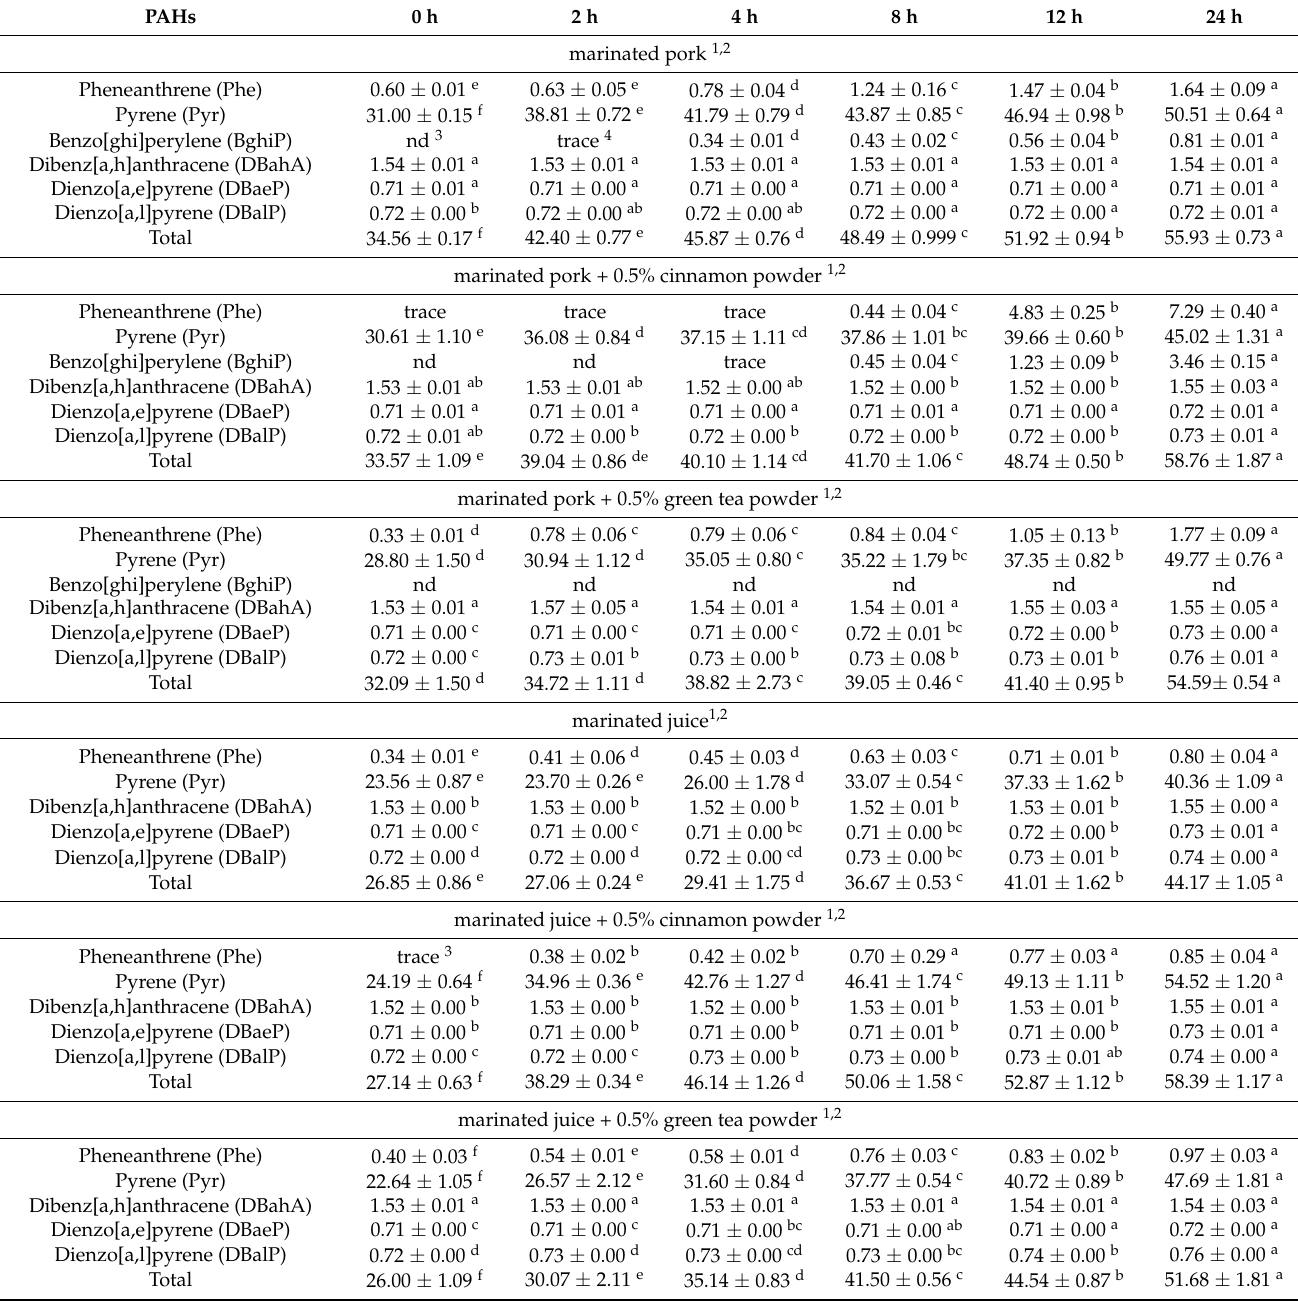
Table 6. PAH contents (ng/g) in marinated pork and juice as affected by different flavorings and time